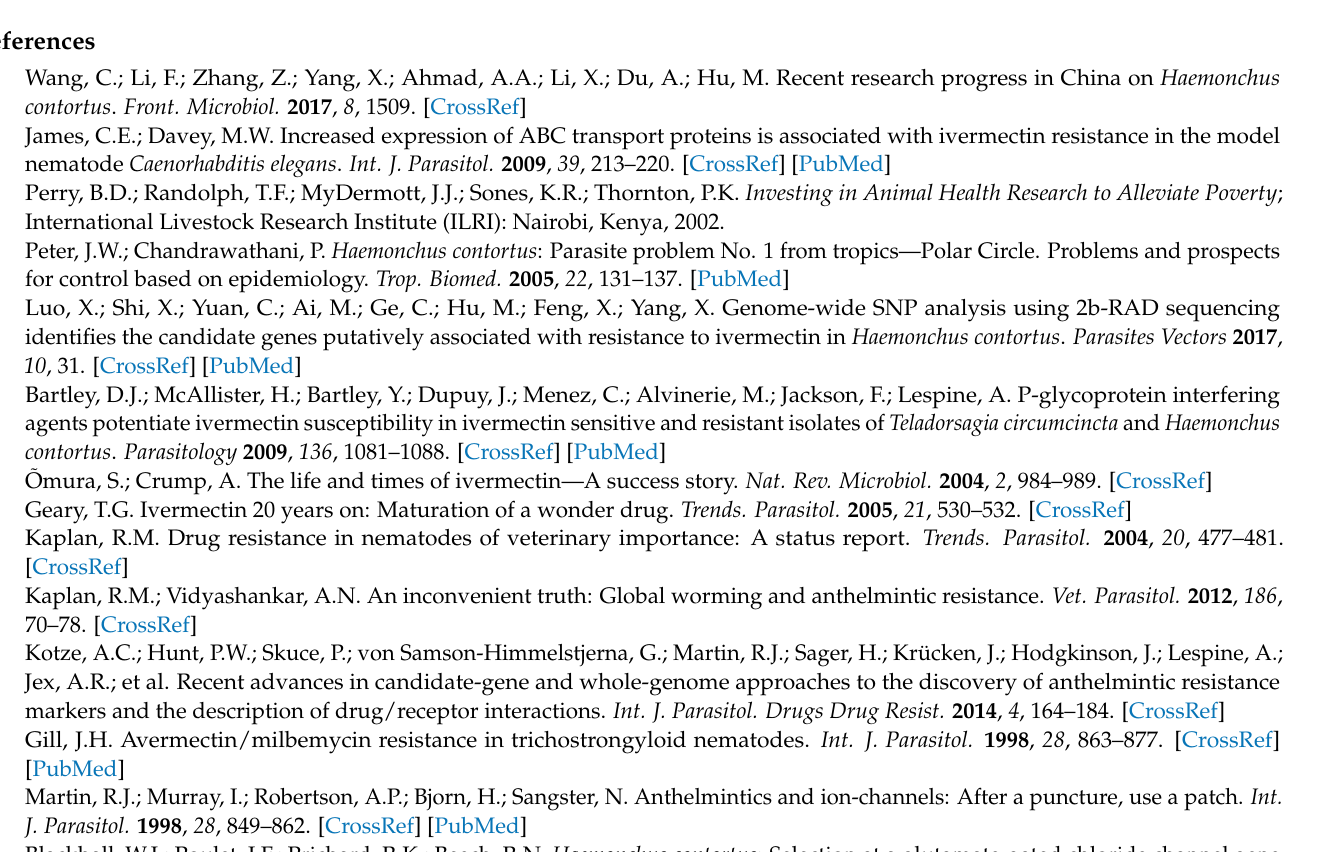
extraction procedure, Table S2: Primer sequences used for q-PCR analysis, Table S3: Quality metrics of the clean